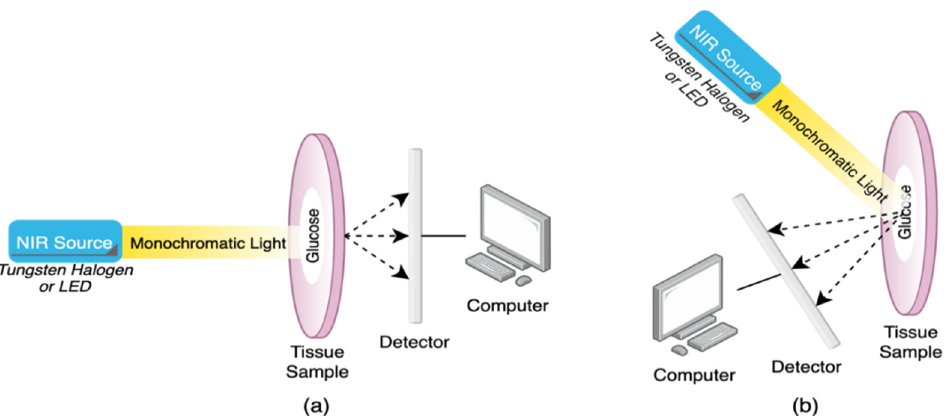
Figure 2. Schematic representation of ( a ) transmission and ( b ) reflection configurations of NIR spectroscopy. In the transmission configuration, the detector is located on the other side of the sample and only the transmitted photons are measured. In the reflection configuration, the detector is located on the same side of the sample and only the scattered photons are measured.